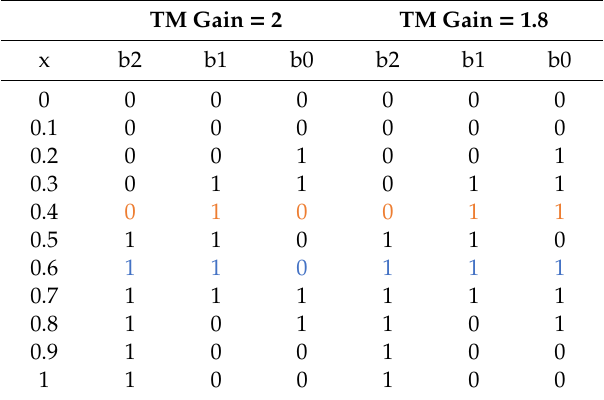
Table 2. Highlighting missing (orange) and incorrect (blue) digital output codes.